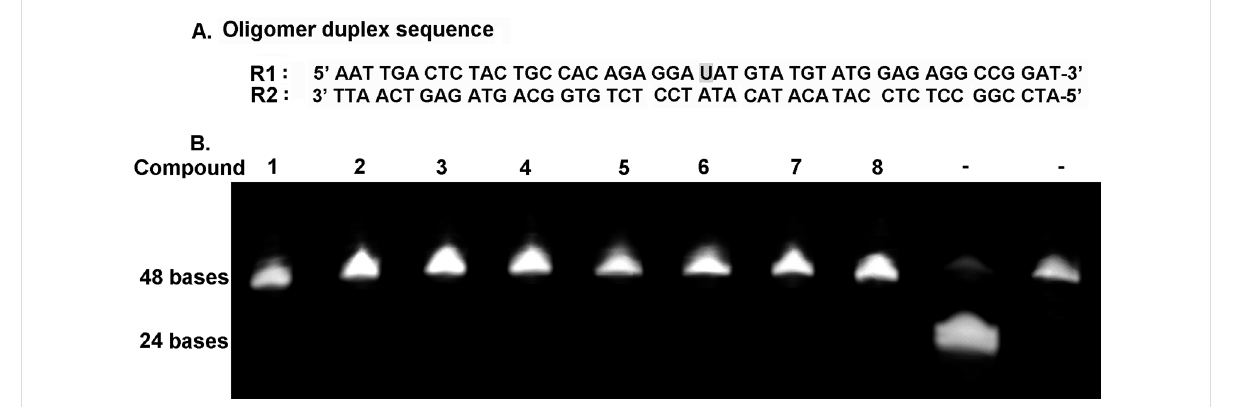
Figure 3: (A) Oligomer duplex sequence that was used to study the effect of triptycene derivatives on the abasic site in DNA. The site of abasic site generation is denoted as U (Uracil). (B) Effect of the triptycene derivatives on abasic sites revealed by polyacrylamide gel electrophoresis (PAGE). The last two gel lanes do not contain any compounds and oligomer duplex DNA in those lanes were treated with UDG + ApeI and UDG only, respect- ively.